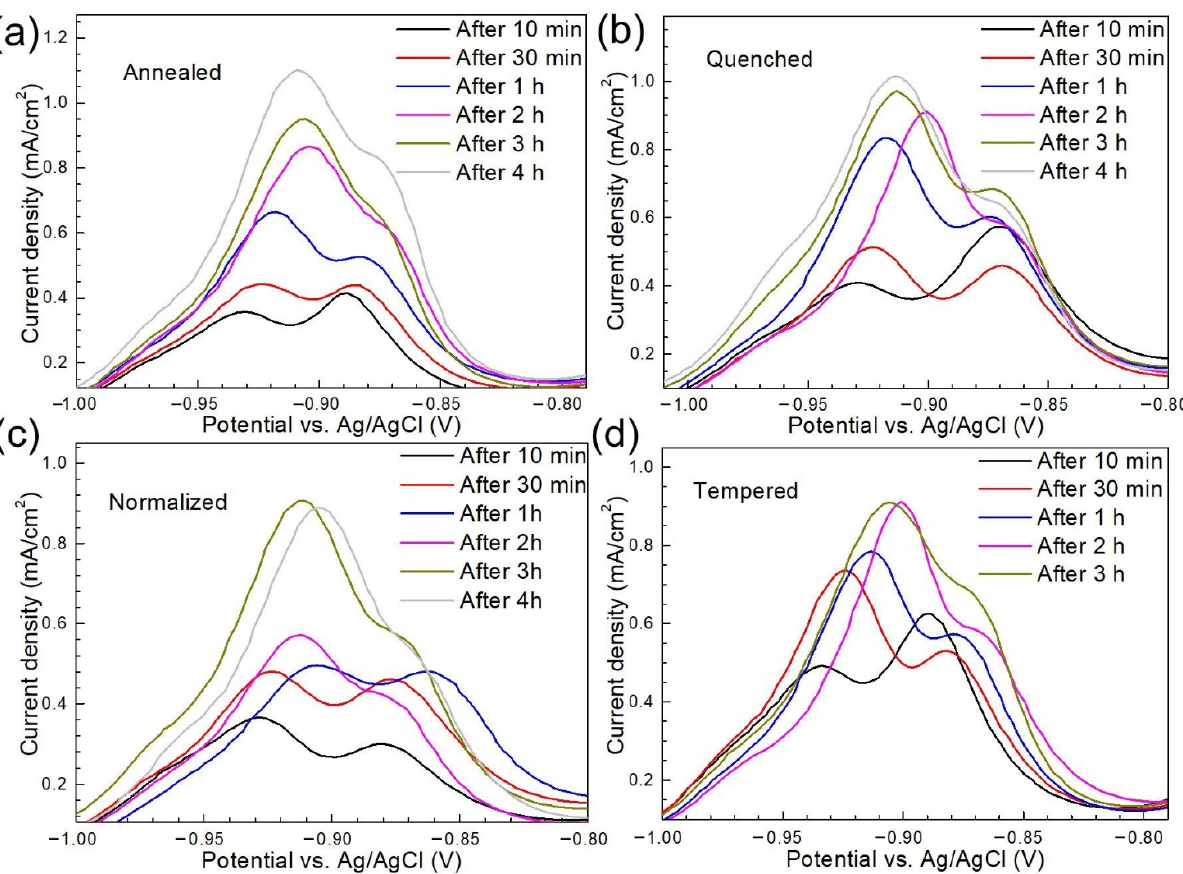
Figure 10. The first CV scans after hydrogen charging for different times in NaOH solution containing thiourea for annealed steel ( a ), quenched steel ( b ), normalized steel ( c ), tempered steel ( d ).